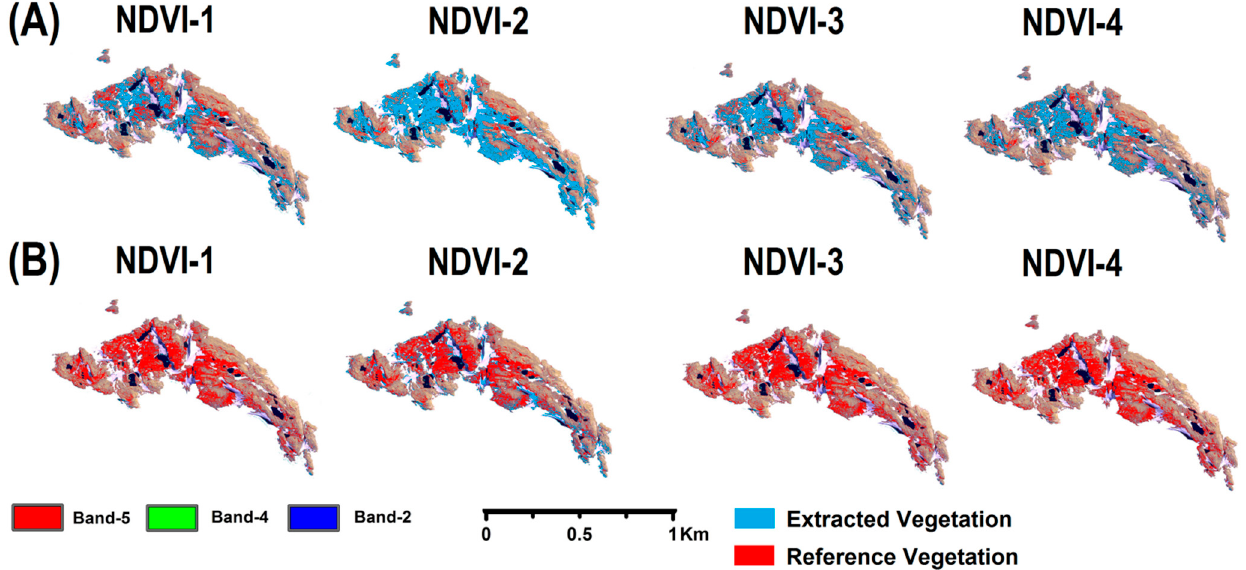
Figure 5. Visual analysis of semi-automatically extracted vegetation (blue coloured) against the manually digitized reference vegetation (red colored) using Normalized Difference Vegetation Index (NDVI) approach. ( A ) Semi-automatically extracted vegetation is overlaid on manually digitized reference vegetation to highlight spatial distribution of underestimated vegetated areas. ( B ) Manually digitized reference vegetation overlaid on the semi-automatically extracted vegetation to highlight spatial distribution of overestimated vegetated areas. All the displayed maps are prepared using Band-5 (630–690 nm), Band-4 (585–625 nm), and Band-2 ( 450–510 nm ) of WV-2 imagery.